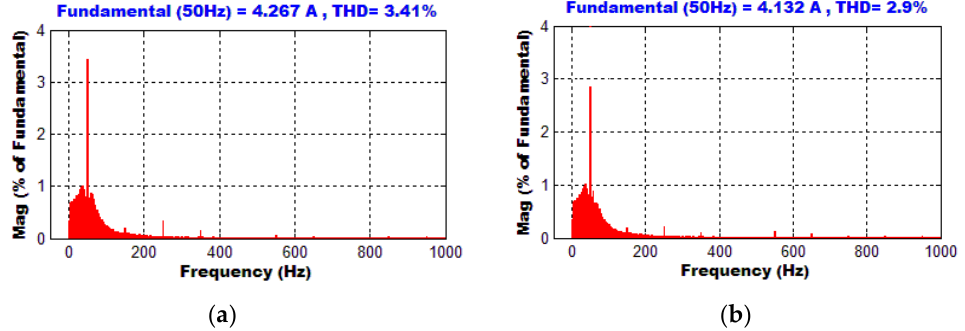
Figure 10. The total harmonic distortion: ( a ) grid current total harmonic distortion (THD) waveform with the conventional proportional-integral (PI) controller; ( b ) grid current THD with whale optimized PI controller.